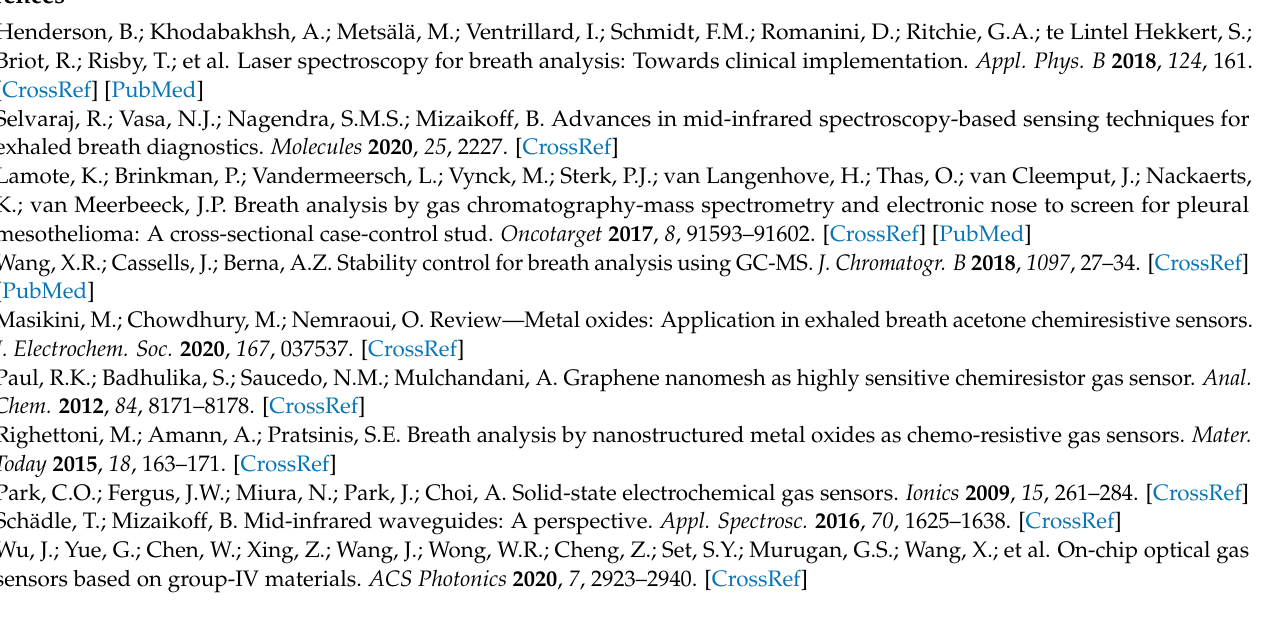
Figure S9: Comparison of controlled and conventional dipping ellipsometric thickness as a function of number of bilayers (A). and cross-sectional SEM images of 1- and 5-BL films at pH 9 (B-E): 1-BL film at 0.001 cm/s (B); 5-BL film at 0.001 cm/s (C); 1-BL film using conventional dipping (D); and 5-BL film using conventional dipping (E). Refractive indices of these films were fitted accordingly. Cross- sectional SEM thicknesses were estimated using ImageJ software analysis of 10 images collected from samples prepared by using several repeated coating depositions, Table S1: Zeta potentials and hydrodynamic diameters for MSN 0.2 wt.% aqueous solutions at pH 7 and 8, Table S2: Dry ellipsometric thickness of a BPEI priming layer as a function of solution pH and substrate withdrawal conditions, Table S3: Total energy and adsorption energy of ethanol and methane molecule on a-SiO 2 surface with and without dipole